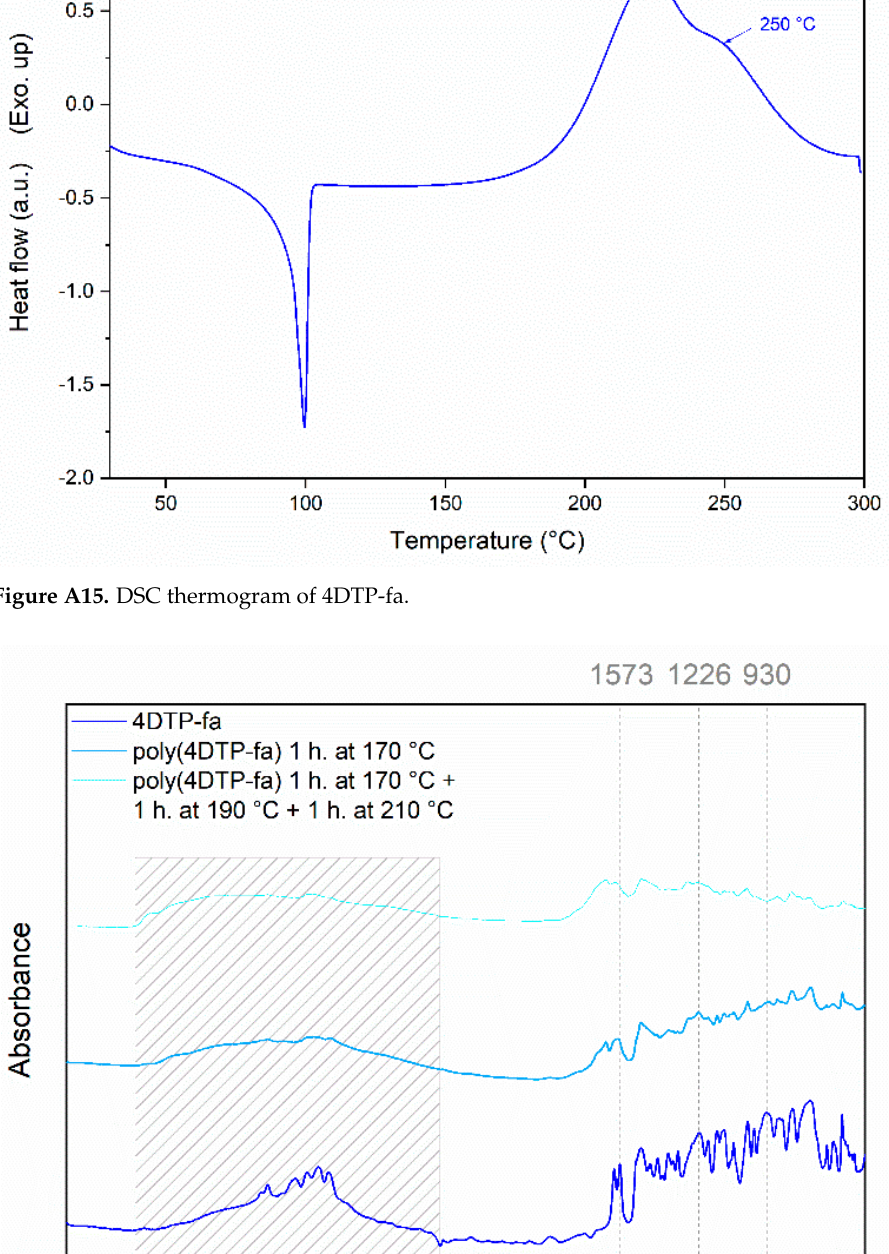
Figure A17. TGA thermogram of 4DTP-fa.